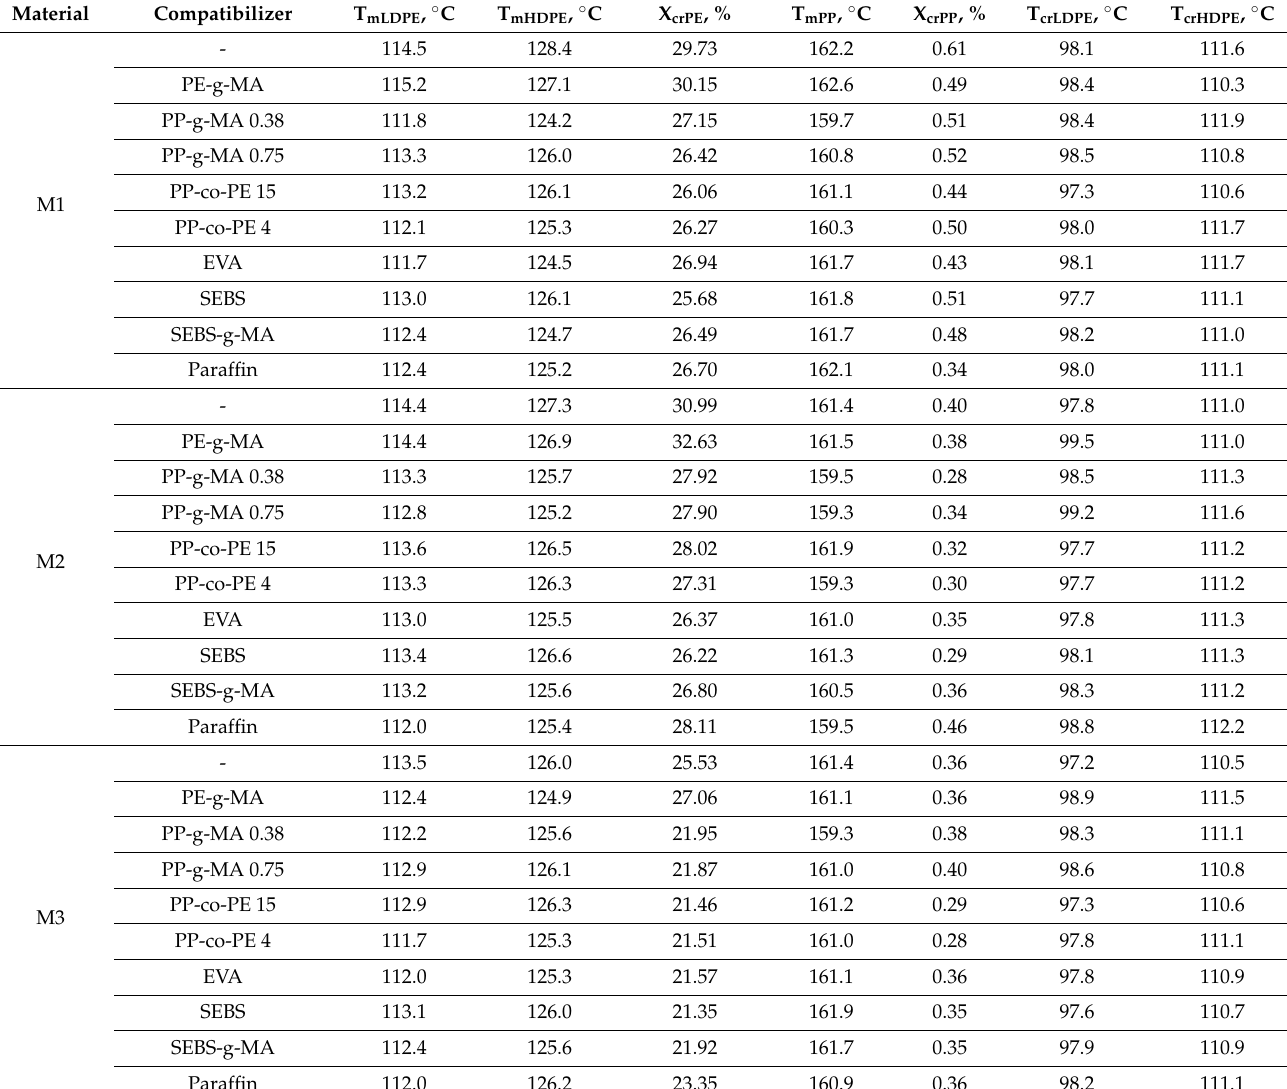
Table 4. Temperatures of melting and crystallization of particular phases and their degree of crystallinity determined for compatibilized M1–M3